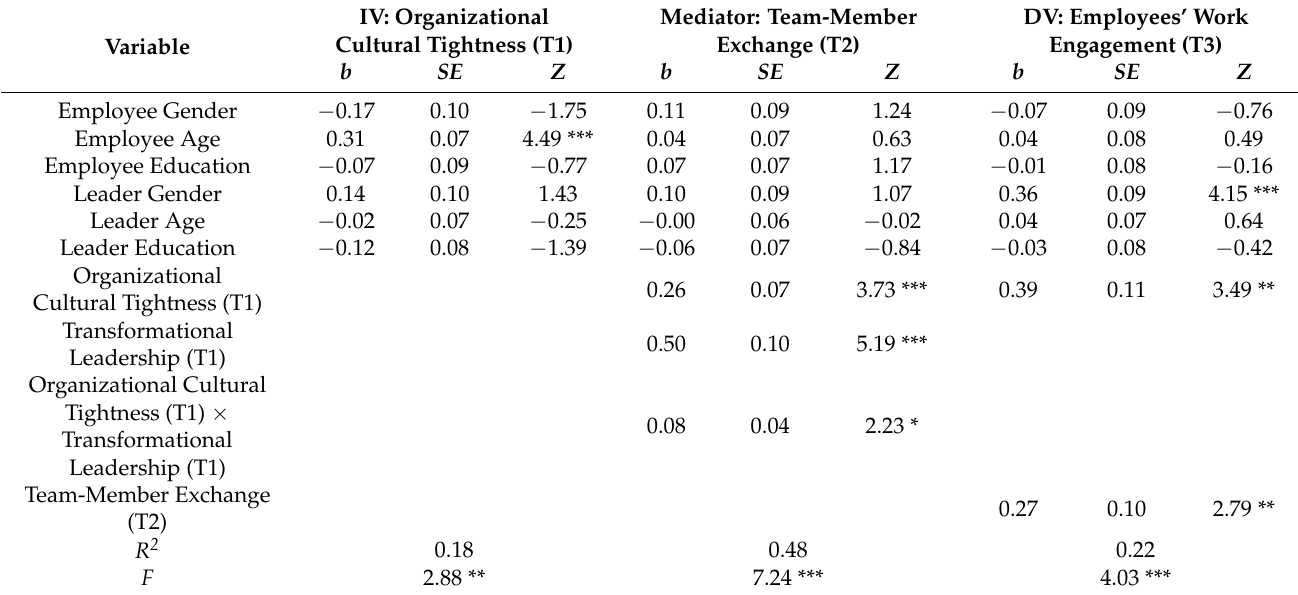
Table 3. Moderated Mediation Analysis.